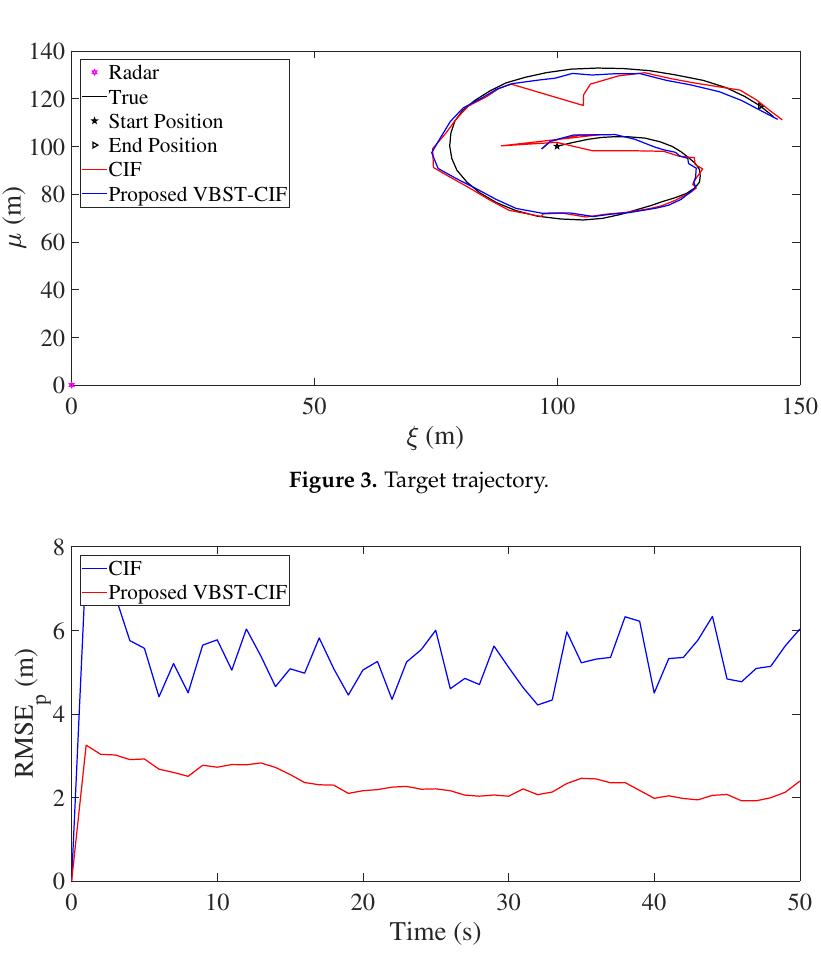
Figure 4. Position root-mean-square-error (RMSE) in single-sensor target